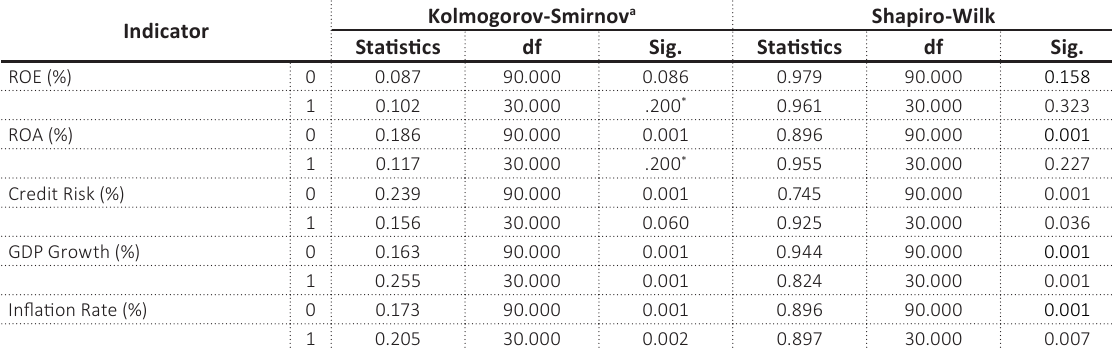
Table 5. Normality test – Thailand vs Malaysia